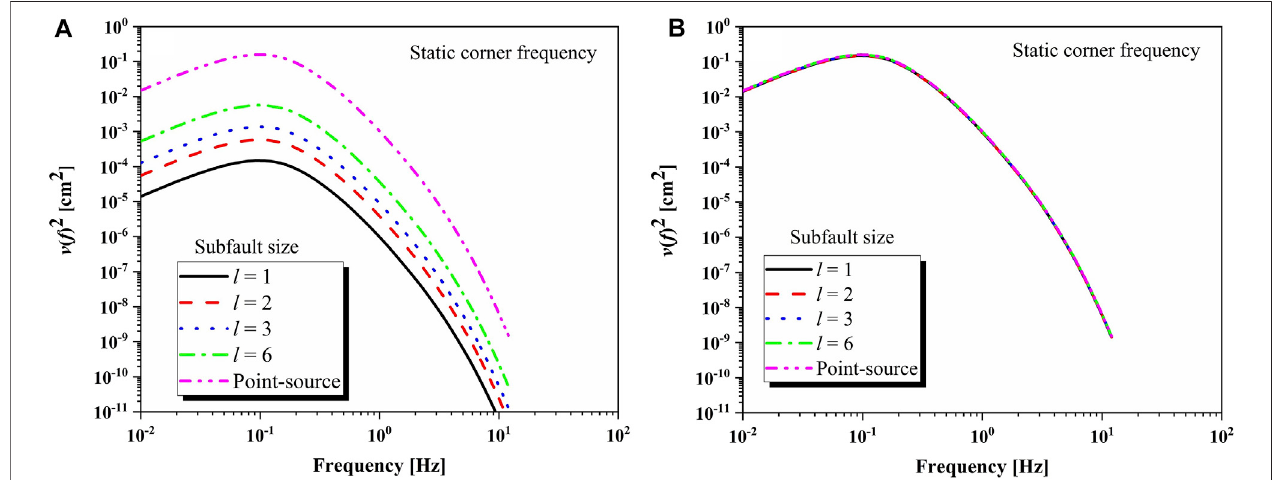
represents the result obtained by stochastic point-source